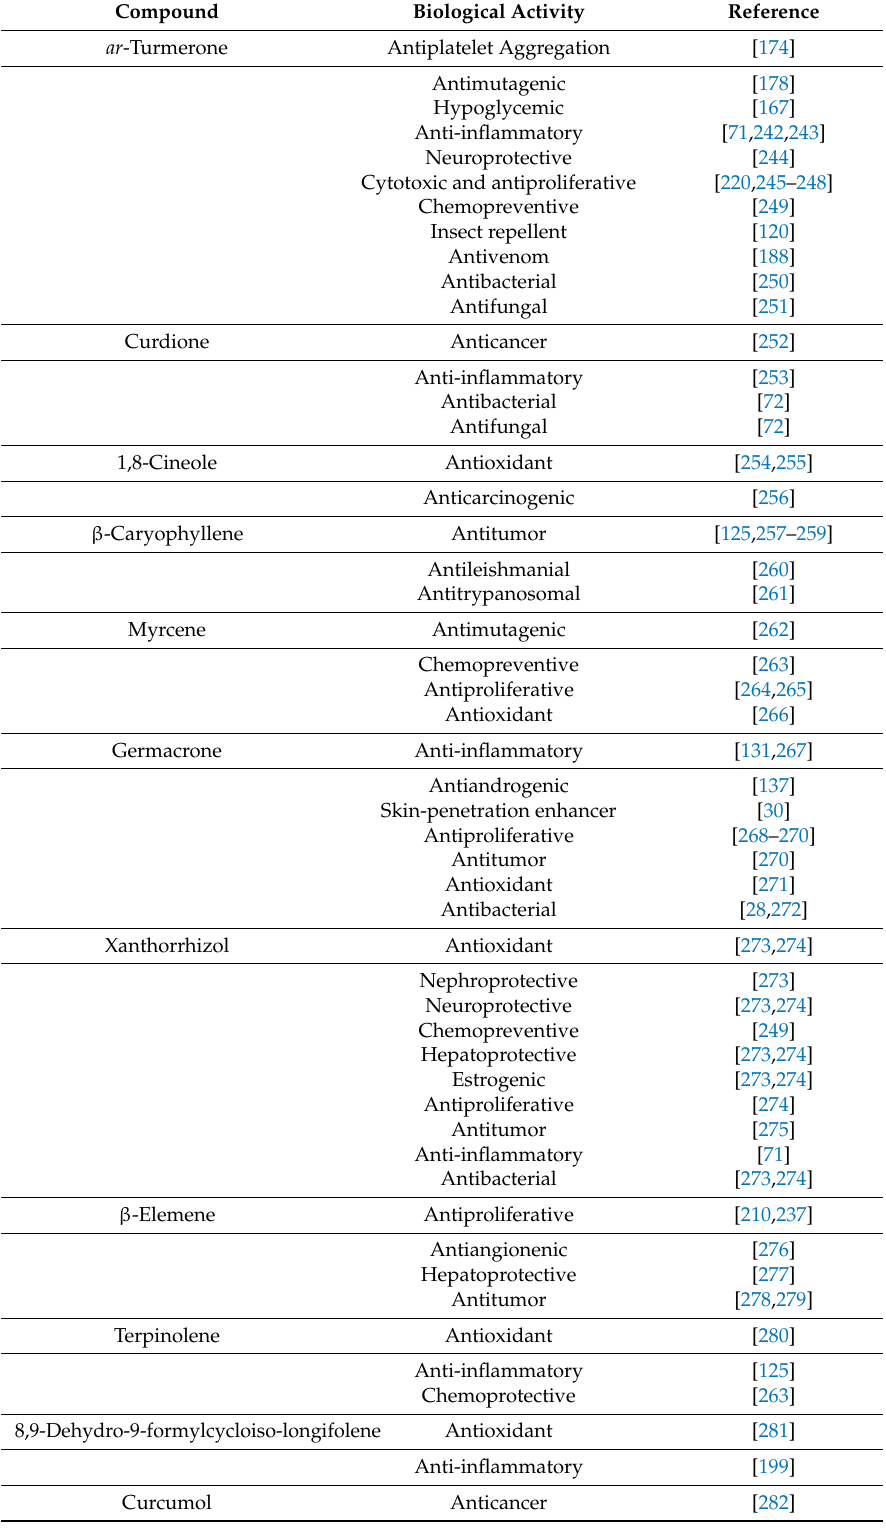
Table 3. Biological activities of key components of Curcuma essential